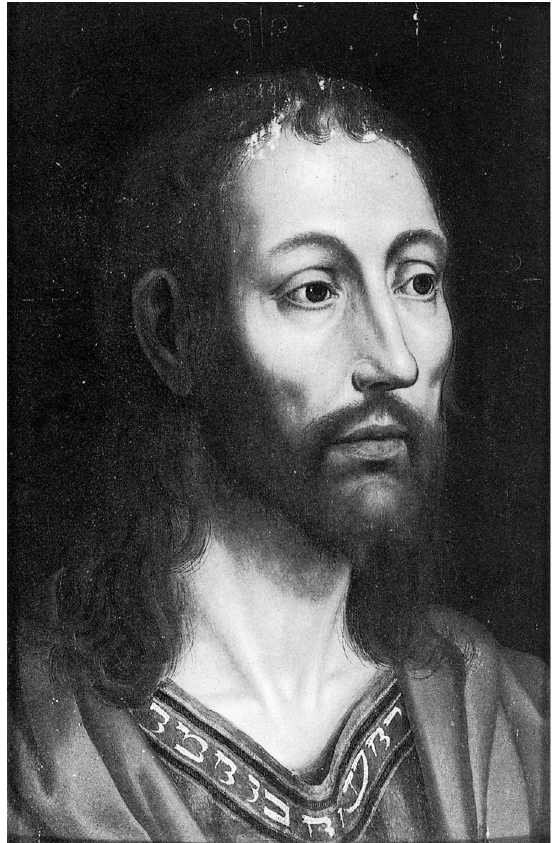
Figure 7. Quentin Massys? Bust of Christ , before 1529? The Hague, RKD Netherlands Institute for Art History. Courtesy of the RKD Netherlands Institute for Art